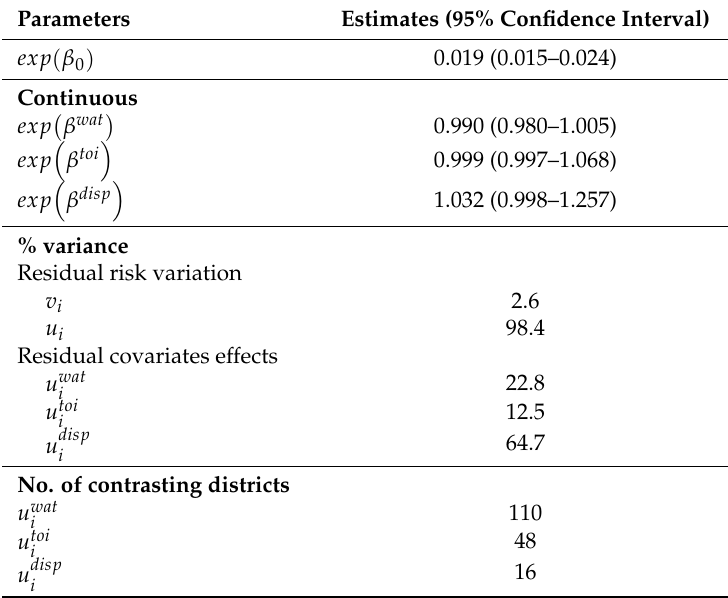
Table 1. Parameter estimates of the Poison-gamma mixture